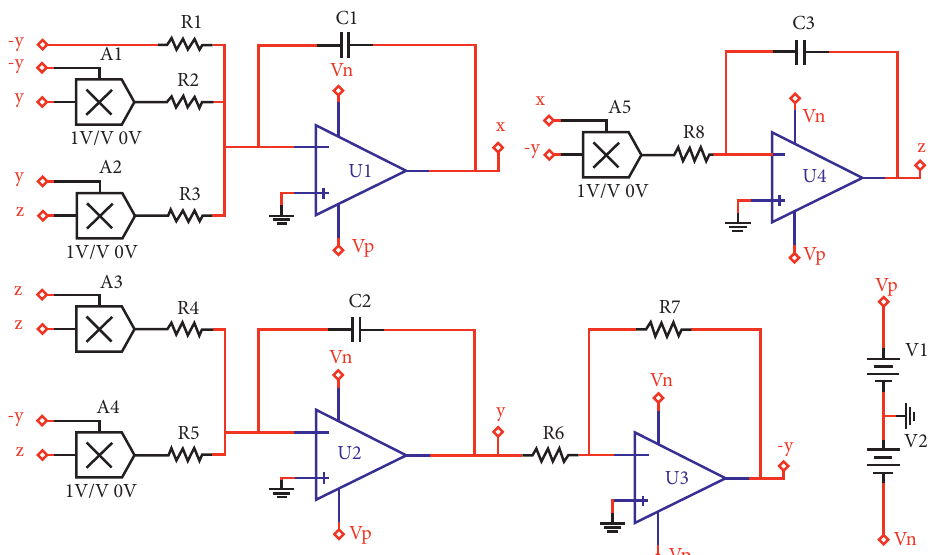
Figure 4: Circuit realization of the system (1).